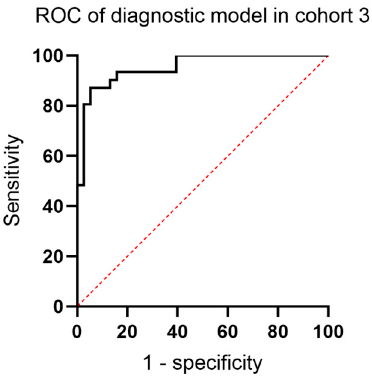
Figure 5. The ROC curve of diagnostic tool consisting of 1 methylation biomarker and 2 SNPs in cohort 3. The classifier of the AUC analysis was ∆ ct value of biomarkers in each sample. We then assessed the model for differentiating different stages and grades of UBC.